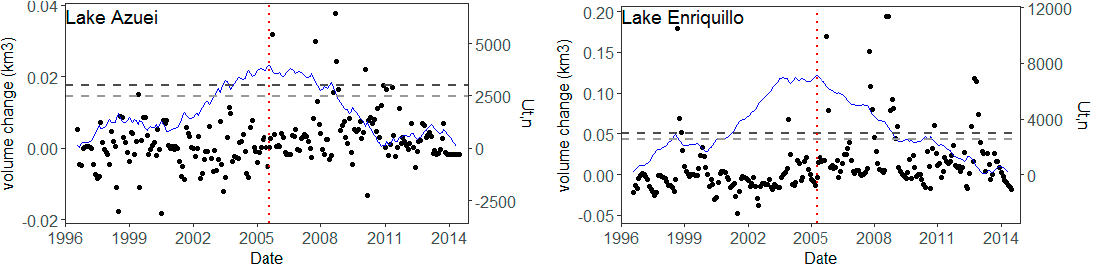
Figure 10. Application of Pettitt test to the lakes’ time series (1996–2014). [Time series values (black colored points), Ut,n (blue line), Confidence level 99% (dark grey dashed line), Confidence level 95% (light grey dashed line), CP (red dotted line)].